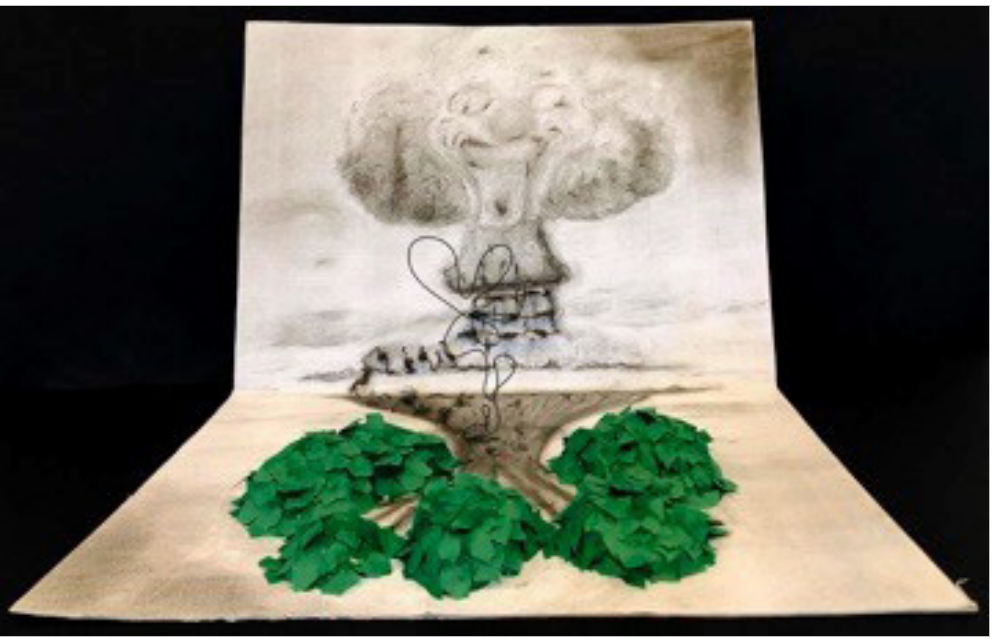
Fig. 4 Student of the Visual and Plastic Art Design workshop, Nuclear clown , 2021. Charcoal on paper, cardboard, wire, papier-mâché